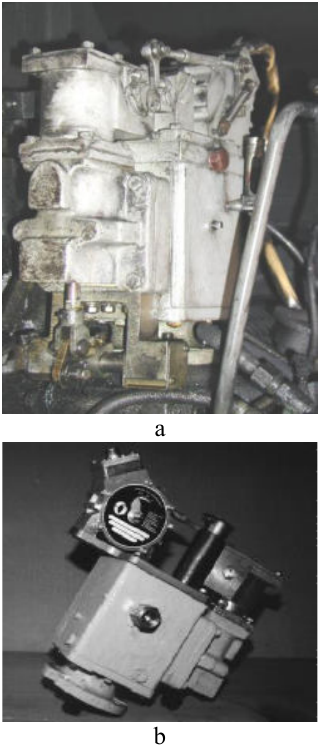
Figure 4. Actuator: ( а ) Mounting on 2TE116 locomotive diesel; (b)